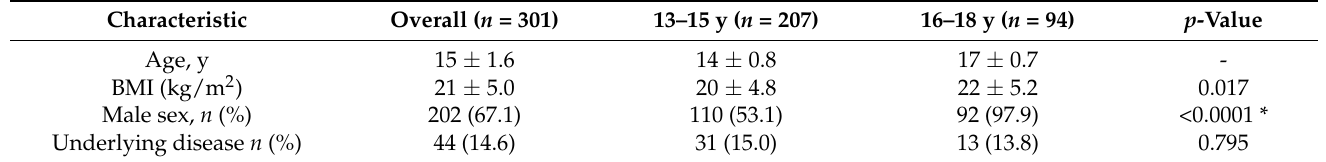
Figure 1. Study flow chart. CK-MB, creatine kinase-myocardial band; ECG, electrocardiography; Trop-T, troponin-T.